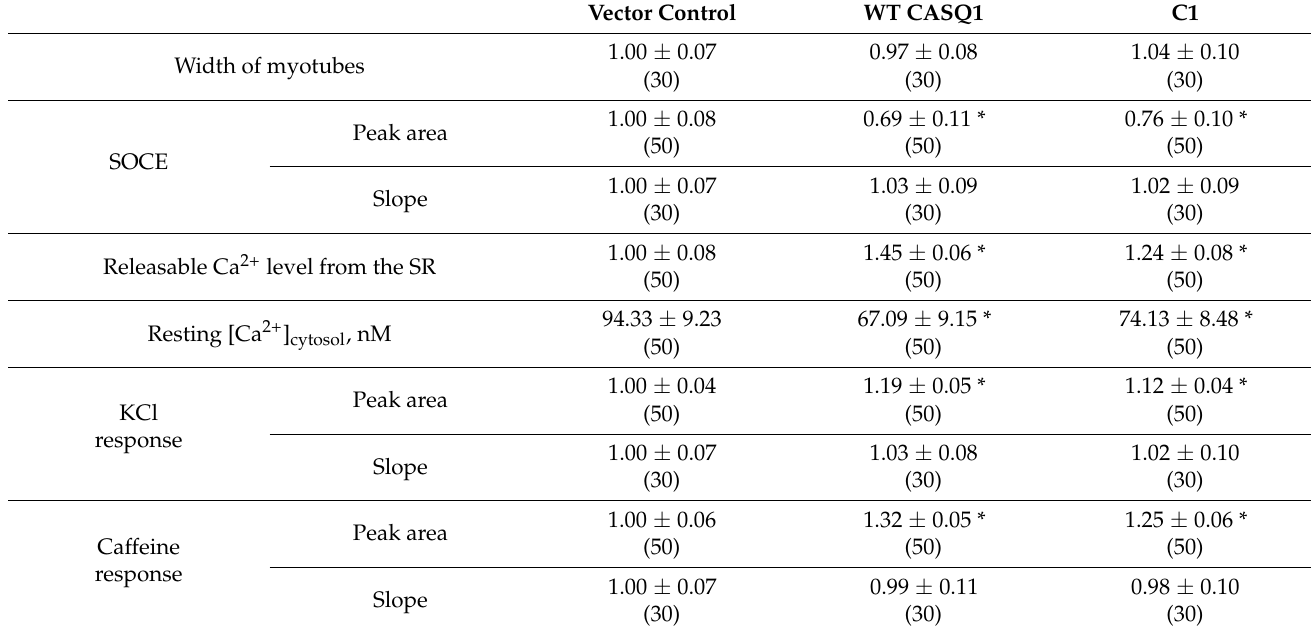
Table 1. Properties of mouse primary skeletal myotubes that expressed the WT CASQ1 or the C1 region. The values, except for those of the cytosolic Ca 2+ levels at rest, were normalized to the mean value of those from the vector control. The values are presented as the mean ± SEM for the number of myotubes shown in parentheses. * Significant difference compared with vector control ( p <